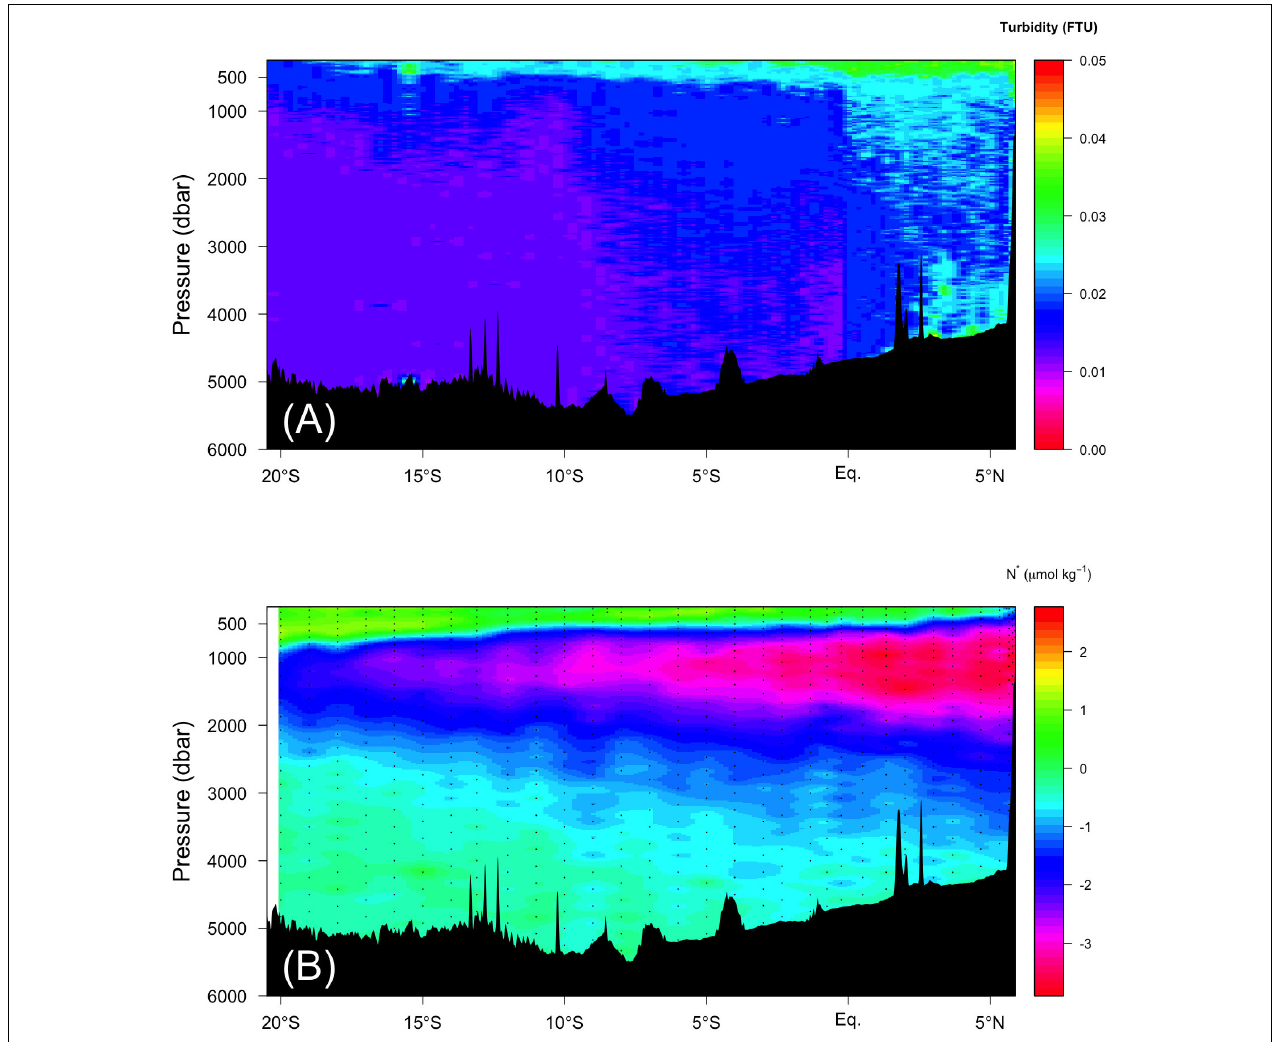
FIGURE 8 | Vertical section of (A) turbidity (FTU) and (B) N* along the Leg 2